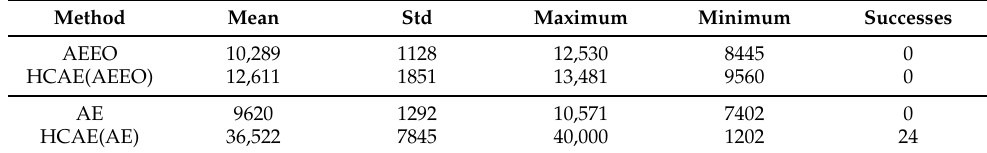
Table 3. Results of the first phase of